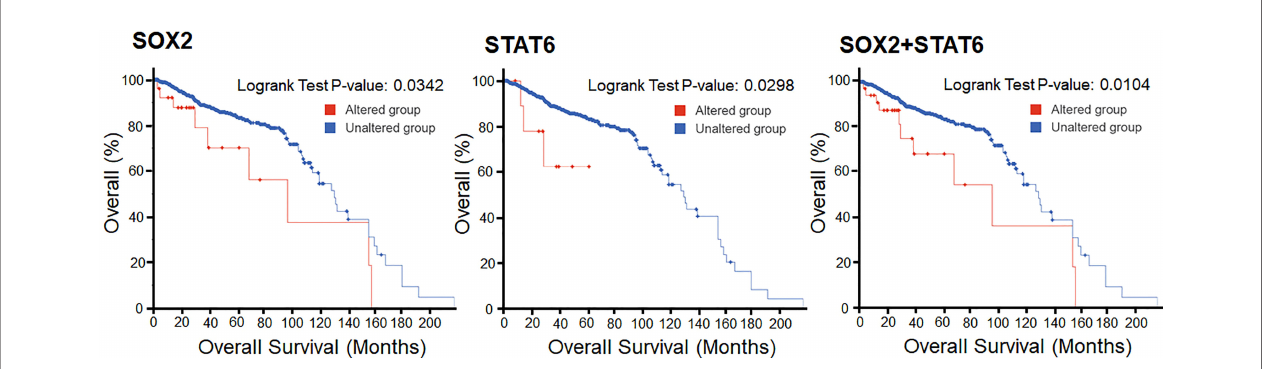
FIGURE 8 | Overall Kaplan-Meier survival estimation of prostate cancer patients in the TCGA dataset. The lower panel shows the tabular status of the Kaplan-Meier